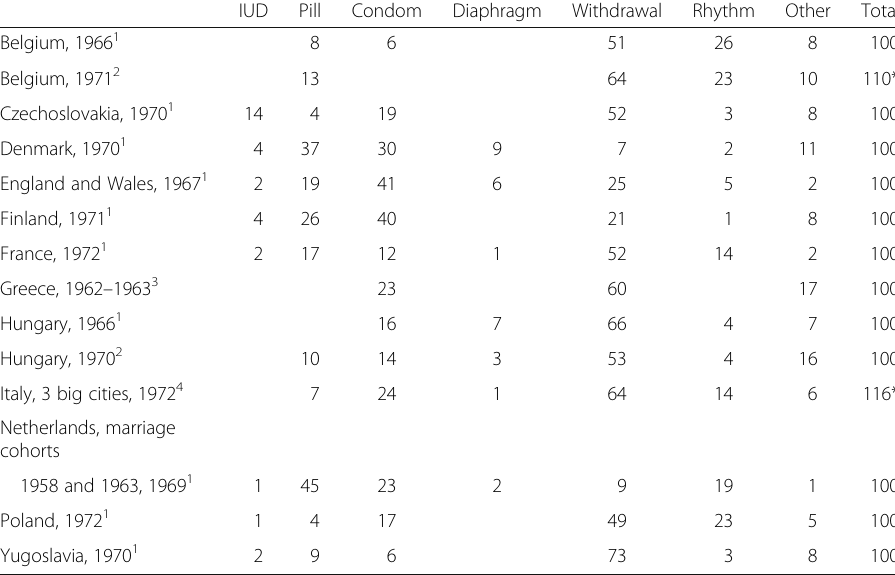
Table 2 Current use of main birth control methods